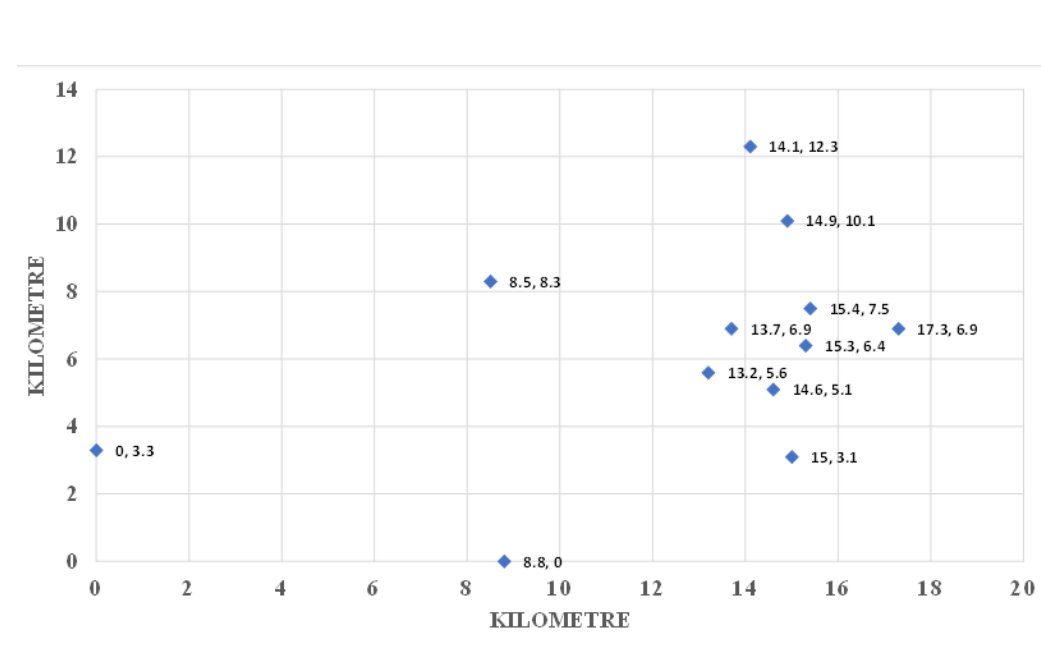
Figure 9. Coordinate distribution map of Wuhan 3A Hospital.